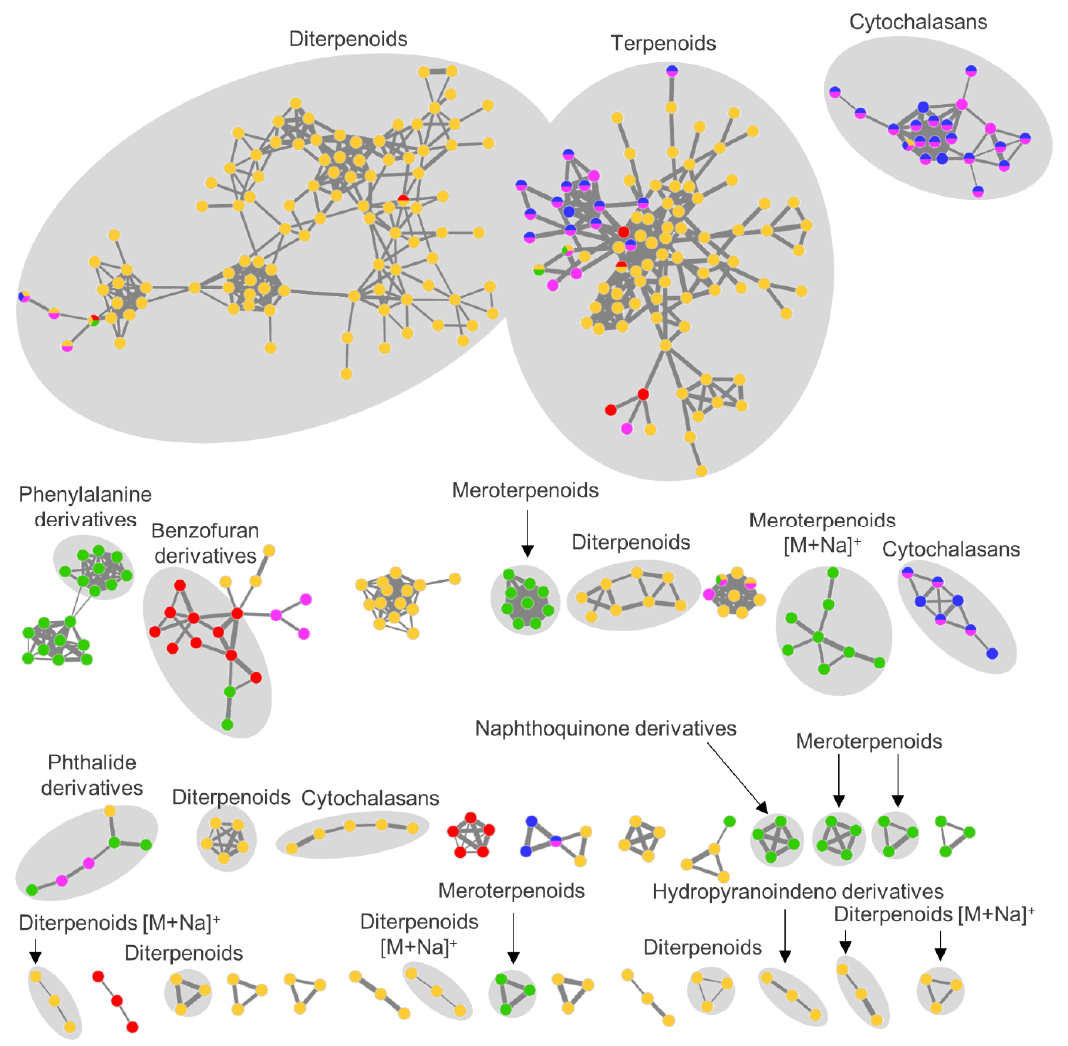
Figure 6. Global FBMN of five bioactive fungal extracts. The FBMN was constructed in GNPS with pre-processed MS / MS data. Molecular clusters containing at least three nodes are displayed and the width of edges corresponds to the respective cosine score. Putatively annotated clusters are highlighted in grey. Fungal extracts are color-coded as follows: red = P. destructans extract CHT56-CAG, yellow = Pyrenochaeta sp. extract CHT58-PDA, green = Penicillium sp. extract CKT35-PDA, blue = B. exigua extract CKT91-CAG, pink = CKT91-PDA. Putatively annotated compounds are listed in Tables S6–S9 in the supplementary.